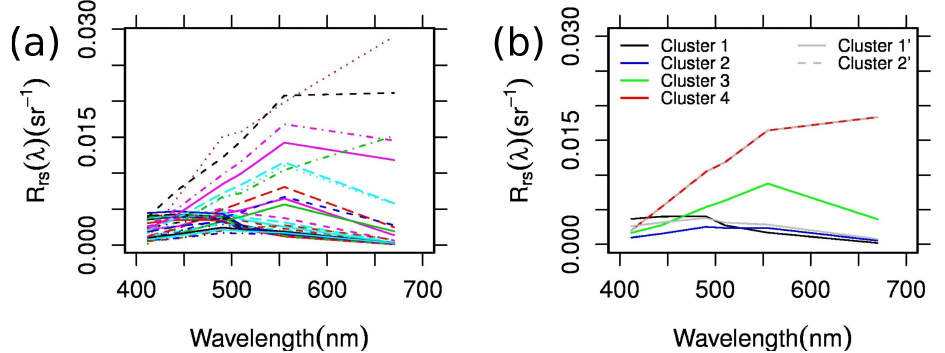
Fig. 3. R rs (λ) spectra observed during the MALINA cruise: (a) all R rs (λ) spectra, and (b) classified R rs (λ) spectra using k-means cluster analysis.